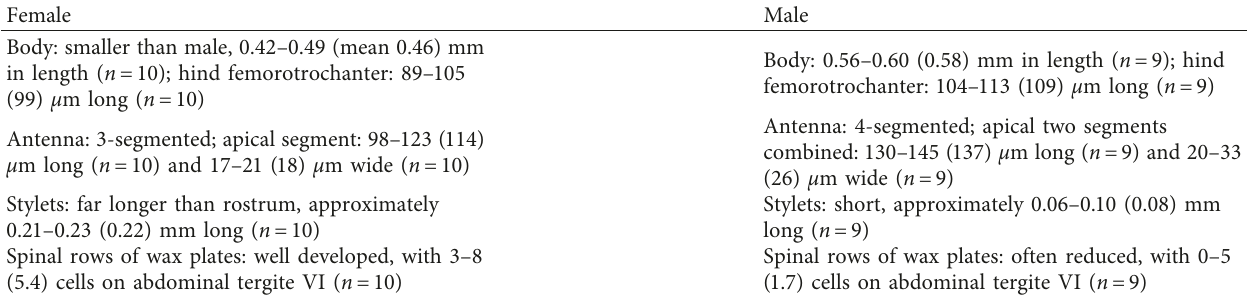
Table 4: Main morphological differences between sexes in the first instar of Neothoracaphis yanonis .